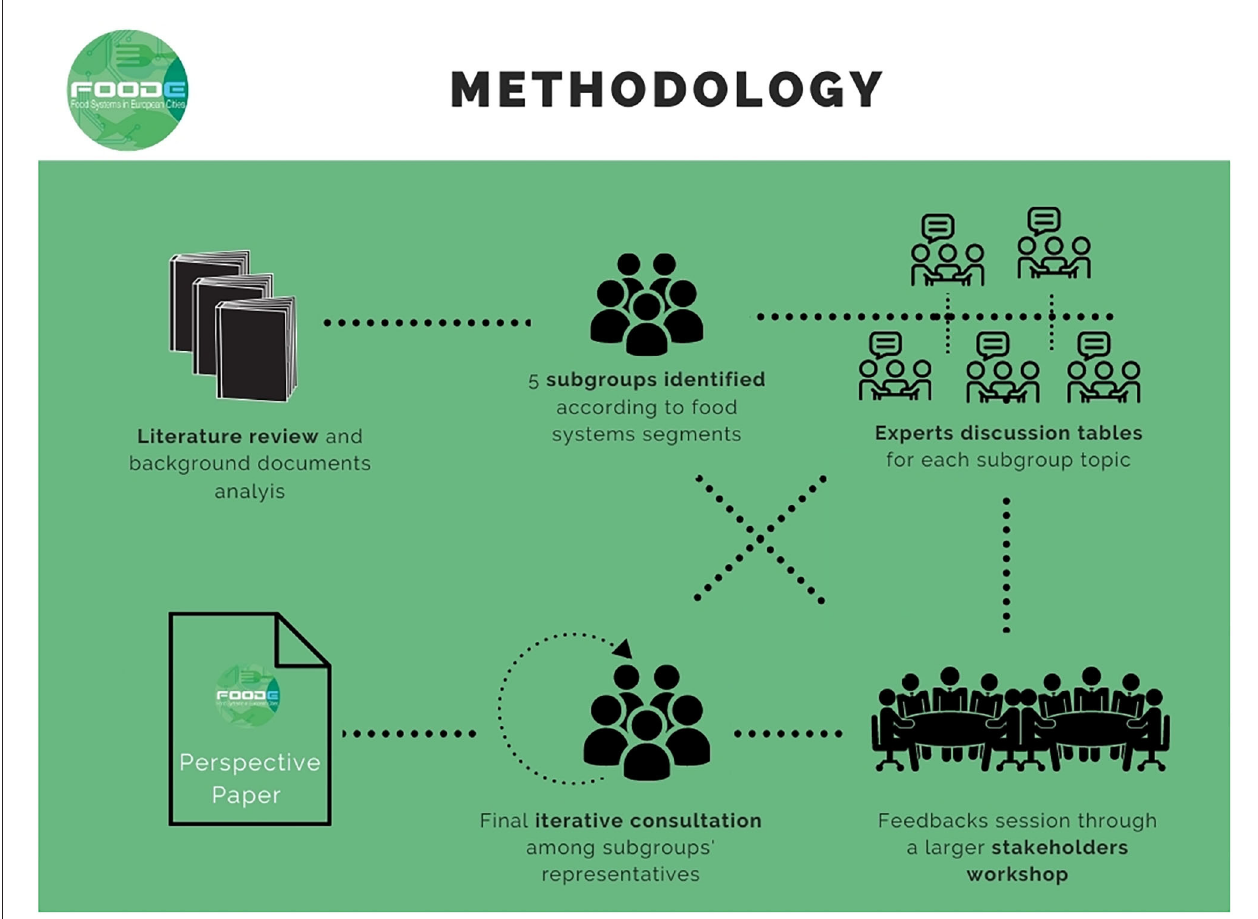
FIGURE 1 | Perspective paper methodological